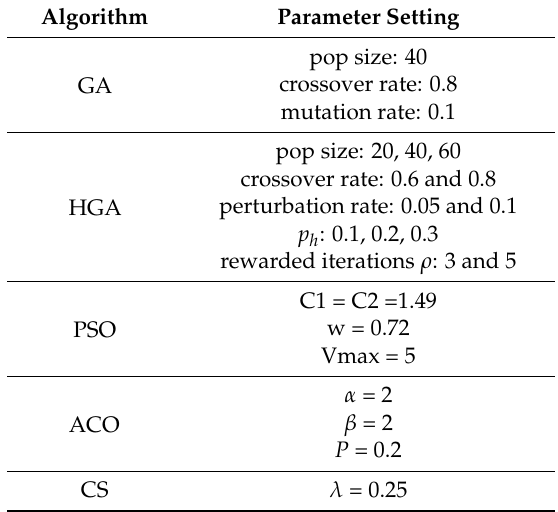
Table 2. Parameter settings for GA.